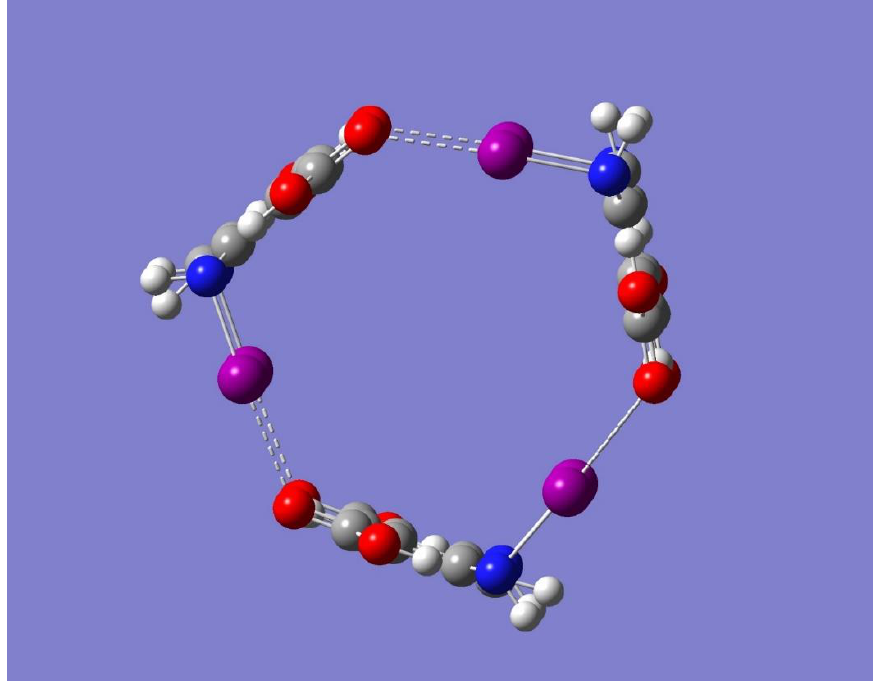
Figure 4. Optimized geometry of the ((HOOC) 2 -C 6 H 2 -(NHI) 2 ) trimer. Intramolecular OH…N hydro- gen bonding and intermolecular NI…O=C halogen bonding indicated with respective dashed lines. Individual atoms can be distinguished by color: C (grey), H (white), N (blue), O (red), and I (purple).